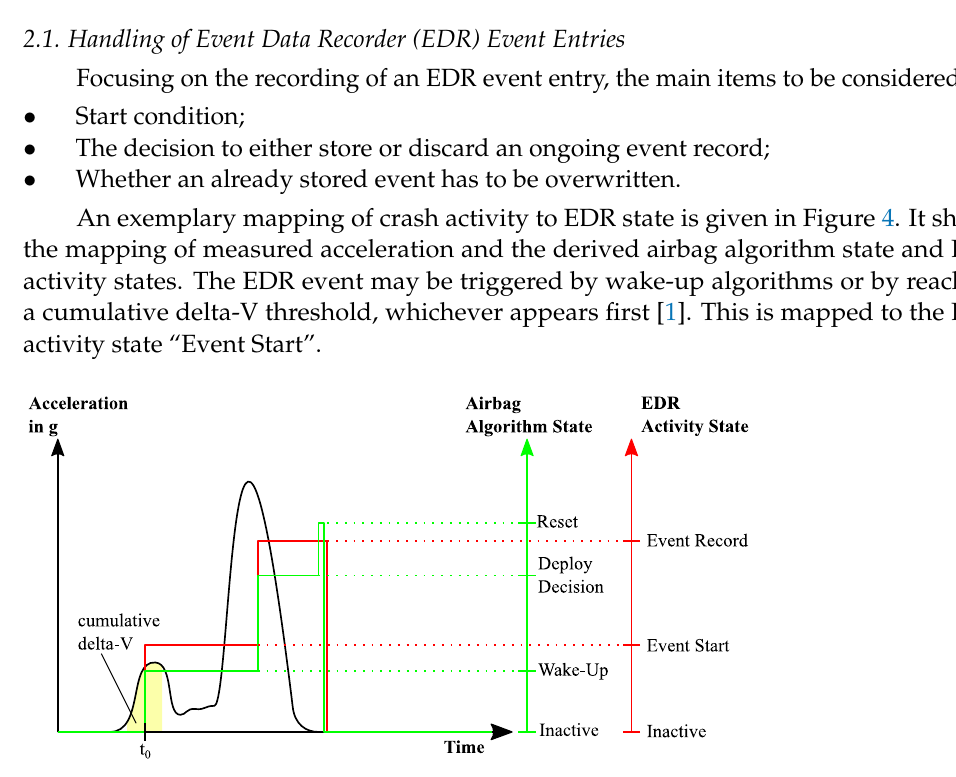
Figure 5. EDR event handling—possible cases: ( a ) single event; ( b ) parallel event; ( c ) multi event; ( d ) trivial event.